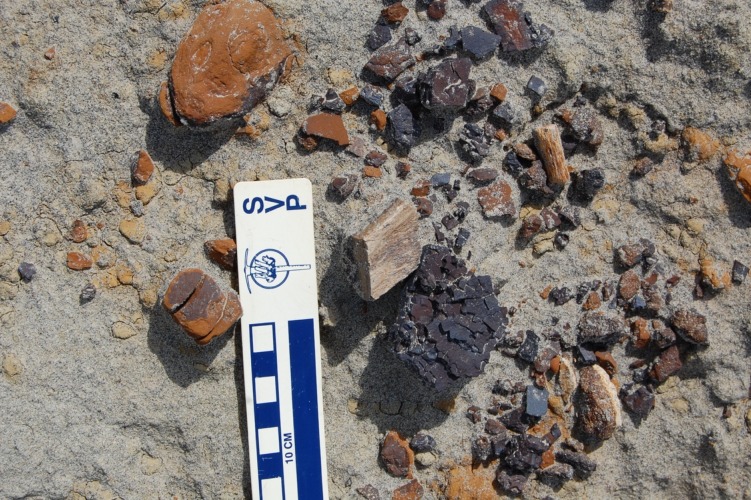
Surface eroded bone fragments from 691 m elevation as they were found.